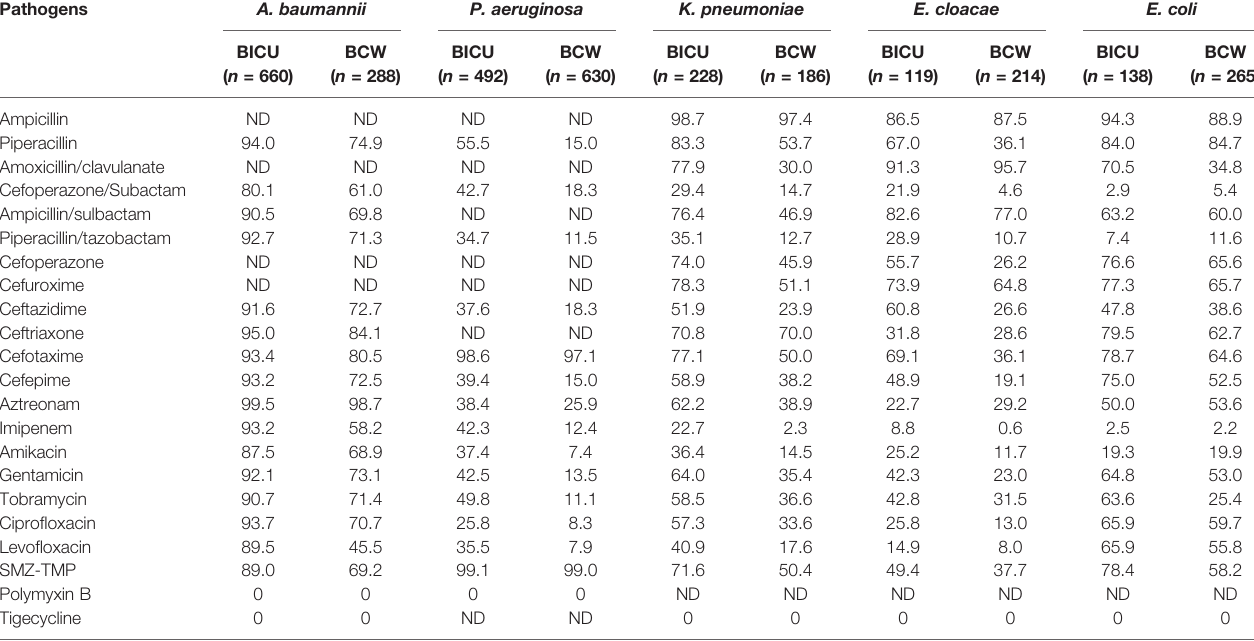
TABLE 3 | Antimicrobial resistance of Gram-negative bacteria in BICU and BCW.